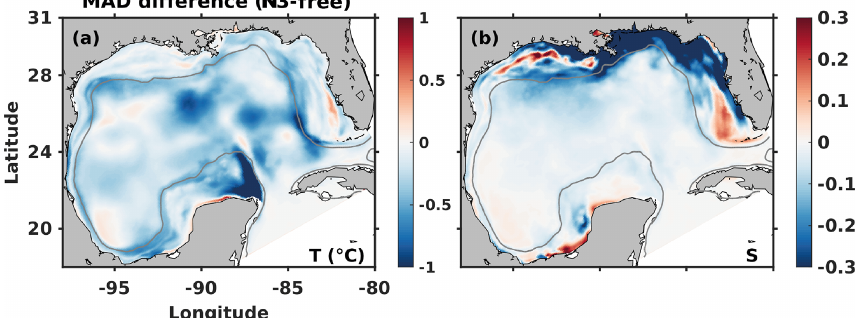
Figure 6. The difference in physical variable time- and water-column-averaged (daily snapshots from 1 April to 1 October) MAD between nonidentical twin N3 and the free run. Negative values (cold colors) correspond to a decrease in MAD compared to the free run, whereas positive values (warm colors) correspond to an increase. The gray contour marks the bathymetric depth of